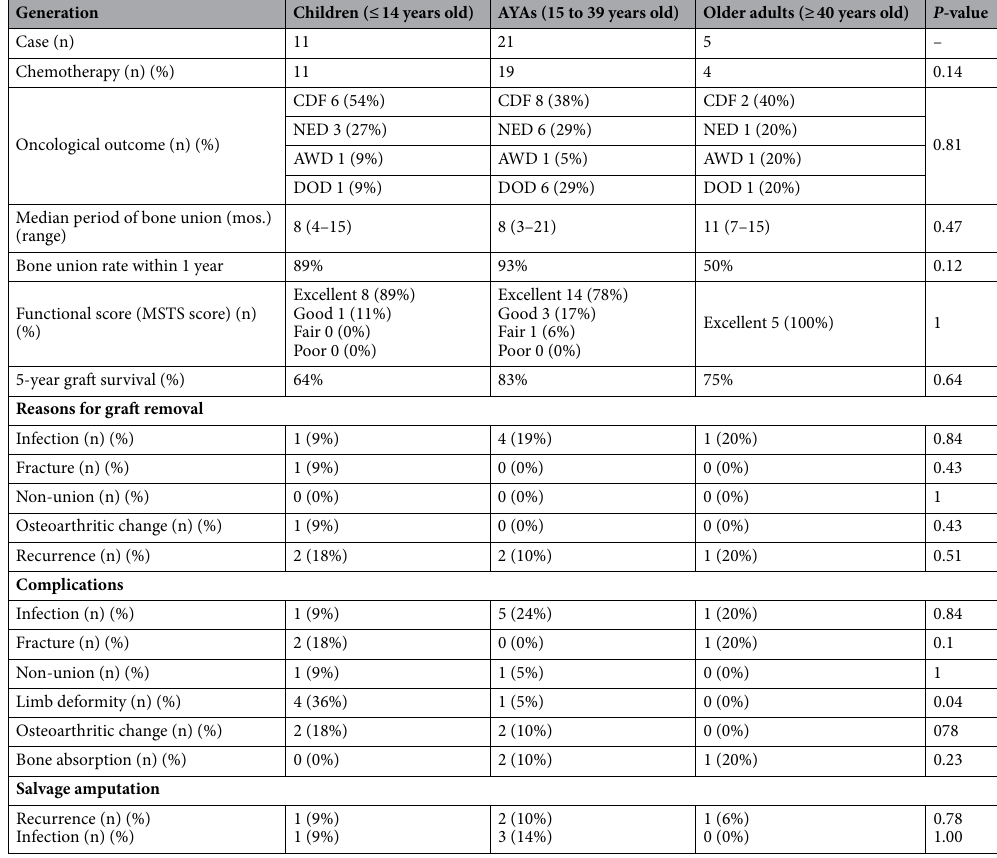
Table 3. The clinical outcomes and complications in the patients who underwent free freezing procedure on the appendicular skeleton in the three age groups. CDF clinically disease-free, NED no evidence of disease, AWD alive with disease, DOD dead of disease, DOOD dead of other diseases, MSTS Musculoskeletal Tumor